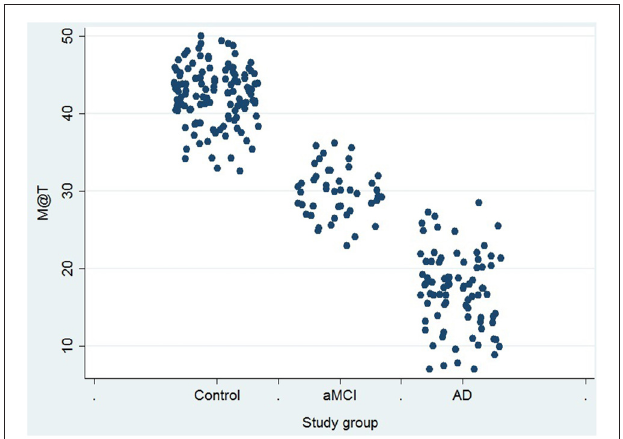
FIGURE 1 | Score in Memory Alteration Test (M@T) in 247 low-level education individuals from Lima-Peru, according to definitive diagnosis. AD, Alzheimer’s dementia; aMCI, amnestic mild cognitive